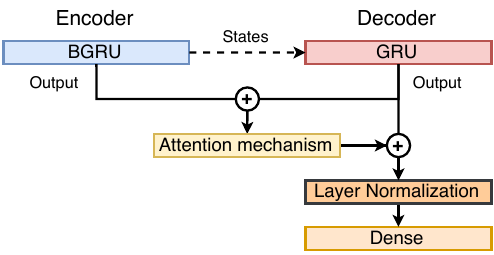
Figure 4. Proposed encoder–decoder architecture using Bidirectional Gated Recurrent Unit (BGRU) as encoder input and Gated Recurrent Unit (GRU) as decoder